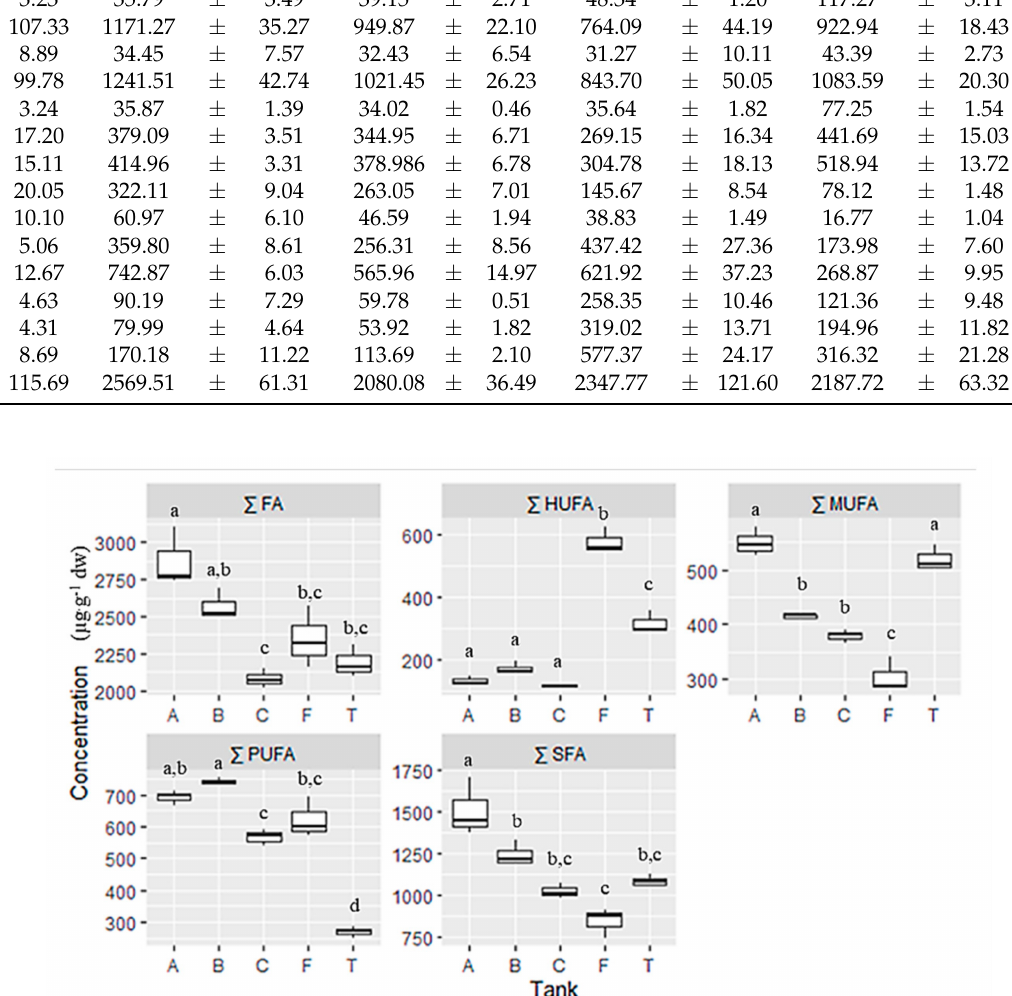
Figure 5. Graphs of each sum of FA group and total FA expressed in µ g.g − 1 of d.w. of Ulva sp. obtained from cultivated in indoor aquaria (A, B, and C), cultivated in outdoor tank (T) and collected from the field (F). In each graph, the same upper letters (a, b, c, and d) mean there are no statistically significant differences between the treatments (cultivation type). Data as mean value distribution and variance; n =